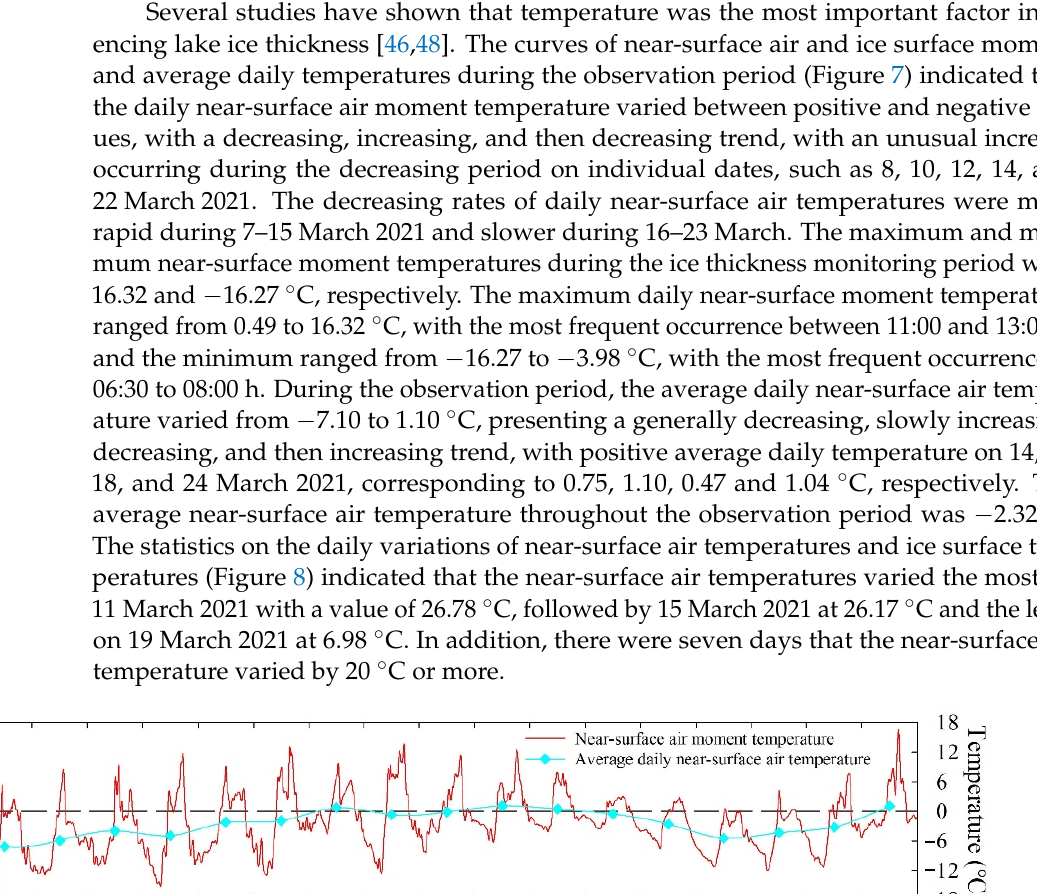
Figure 8. Daily variation of near-surface air and ice surface temperature. In daily morning ice thickness variations, there was an anomalous decrease on 13 March 2021 during a continuous ice thickness increase, 8–14 March 2021, and an anoma- lous increase on 19 and 22 March during a period of continuous ice thickness decrease in 14–24 March 2021. Analysis of the moment temperature changes of the ice surface and near-surface air showed that the ice surface moment temperature was higher in the early hours of 13 March than it had been during the night, 7–12 March. From the night of 18 March to the wee hours of 19 March and the night of 21 March to the early hours of 22 March, both the near-surface air and ice surface temperatures decreased to different de- grees. On 19 March 2021, the ice surface temperature decreased slightly while reaching the lowest value for several days on the early morning of 22 March. Therefore, we con- cluded that the lake ice thickness was sensitive to the temperature on the ice surface and played a decisive role in the changes in lake ice thickness, while other meteorological fac- tors had not been considered. Moreover, decreasing temperatures increased lake ice thick- ness, but increasing temperatures thinned it. A certain thermal relationship between the lake ice surface temperatures and the lake ice thickness was shown in a previous study [50]. The cumulative temperatures of the ice surface were an important physical quantity. In the study by Qu et al. [12], they found that Nam Co Lake had a significant association between the freezing period of the lake ice and the negative winter cumulative temperature during the period 2006–2011. Zhang et al. [49] studied the relationship between positive cumulative temperatures of the ice and lake ice thickness during the ablation period of the Wuliang Suhai lake and found a good correlation between them. During the observation period, the combination of snow cover on the ice surface and alternating ice temperatures between positive and negative values